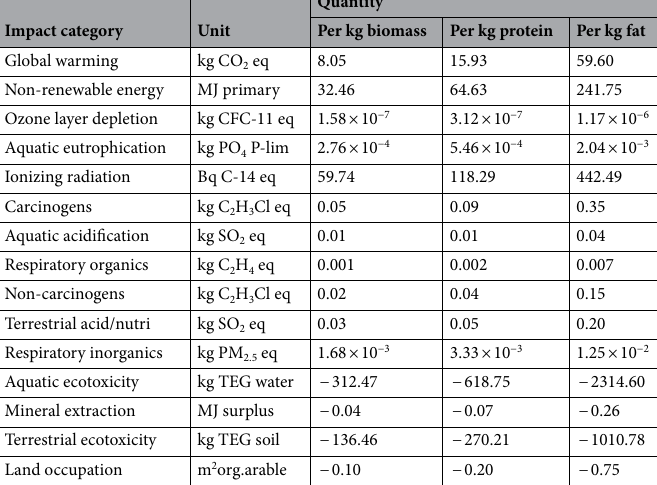
Table 3. Characterization indices of Protaetia brevitars seulensis production. Negative values refer to savings and positive values refer to impacts.